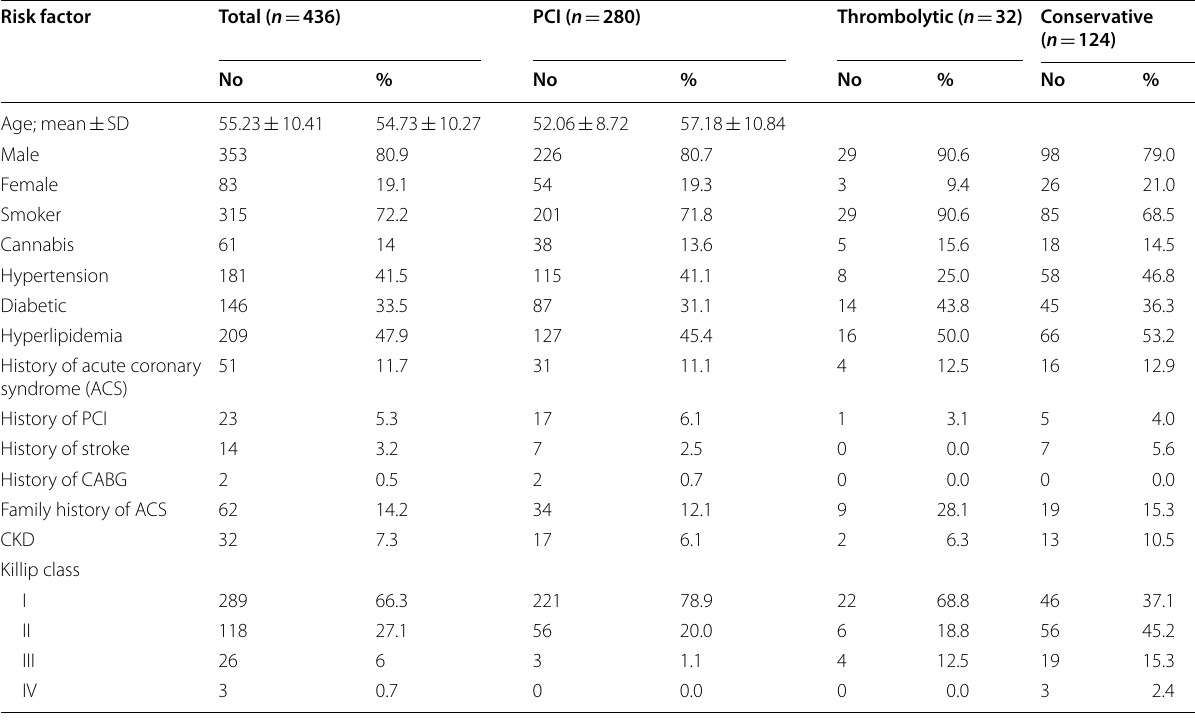
Table 4 Comparison between the different studied types of management according to risk factors and Killip Class on presentation